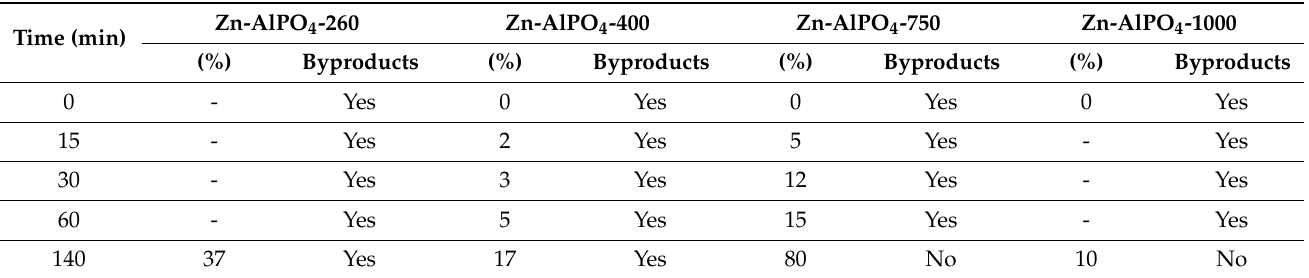
Table 4. Photodegradation of fipronil as a function of time in the presence of 153 mg of Zn-AlPO 4